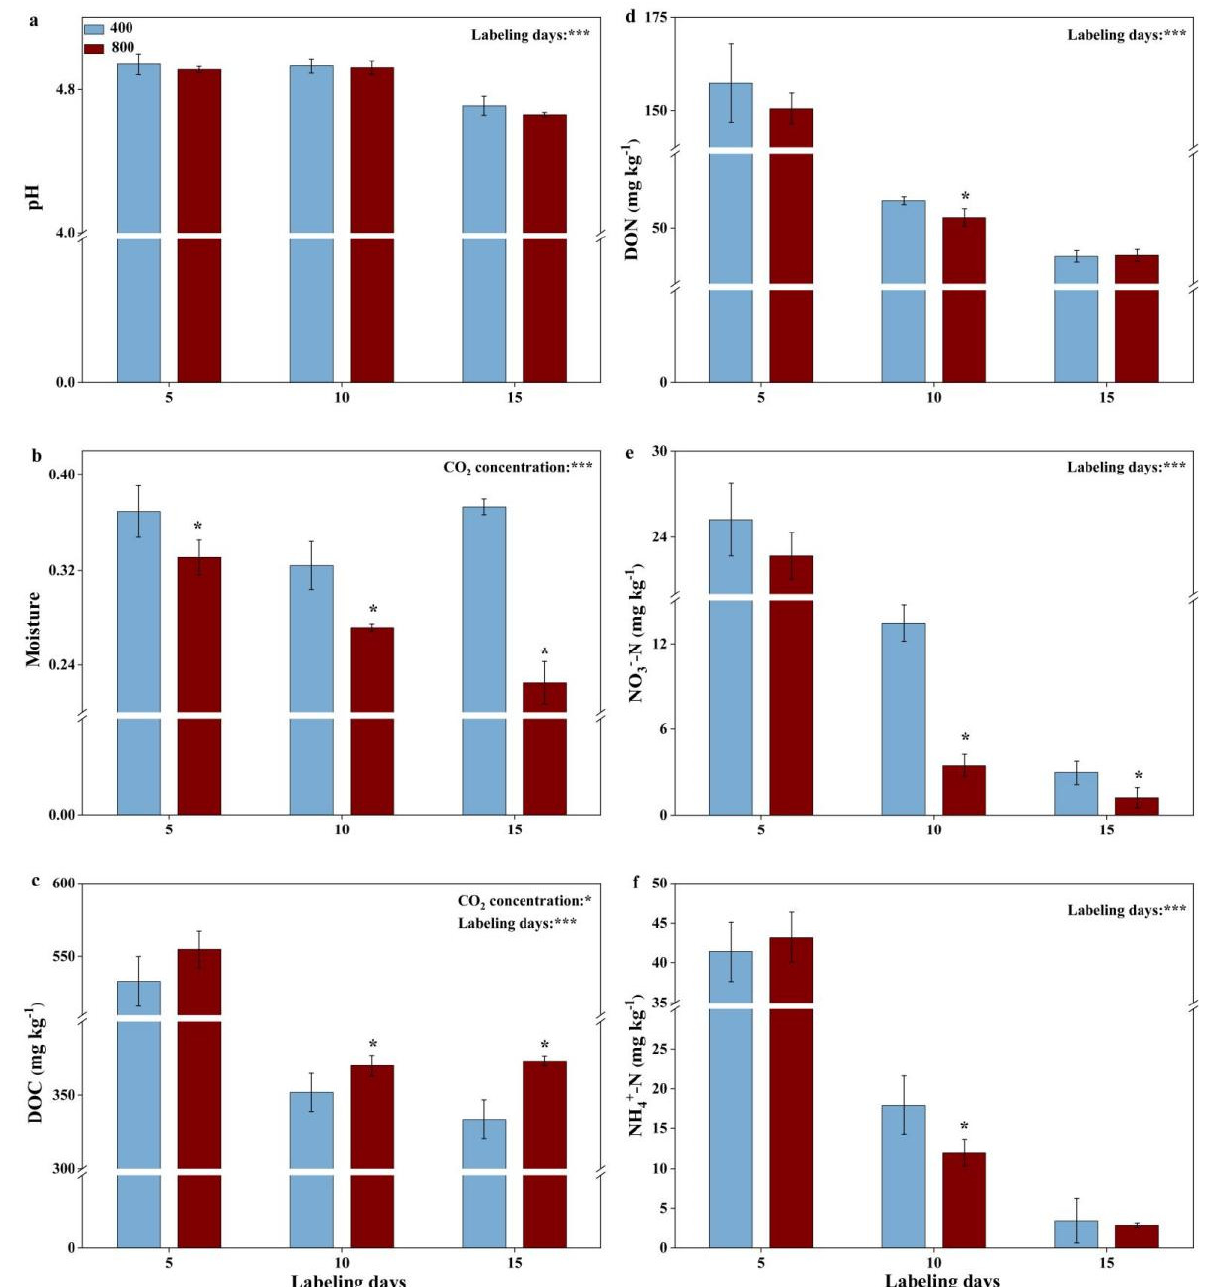
Figure 2. Changes in pH ( a ), moisture ( b ), DOC ( c ), DON ( d ), NO 3 − − N ( e ) and NH 4+ − N ( f ) during the 15 labeling days under both the 400 and 800 treatments. 400:400 µ mol · mol − 1 CO 2 treatment; 800:800 µ mol · mol − 1 CO 2 treatment. Bars represent the standard errors of the means ( n = 4). *: p < 0.05; ***: p < 0.001.